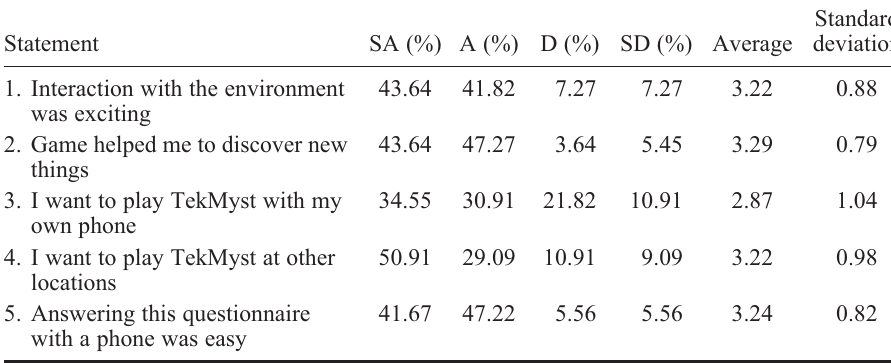
Table 3. Results of the mobile questionnaire for TekMyst.